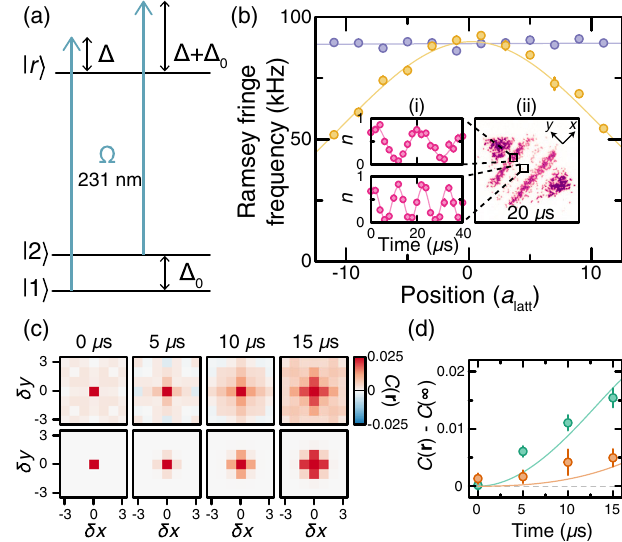
FIG. 2. Measuring Rydberg-dressed interactions with many- body Ramsey interferometry. (a) Energy level diagram for 6 Li showing that the dressing of the other hyperfine ground state cannot be ignored. Here, Δ = 2 π is varied between 30 and 100 MHz, while Δ 0 = 2 π ¼ 75 . 806 ð 1 Þ MHz. (b) Ramsey fringe frequency measured at a detuning of Δ ¼ 2 π × 100 MHz at different positions in the cloud. The frequency is almost constant along the propagation direction of the beam (purple). In the transverse direction (yellow), it varies rapidly as expected for a FIG. 1. Realization of a t − V model with Rydberg dressing. tightly focused Gaussian beam. Insets: (i) Ramsey oscillations at (a) The Rydberg-dressing beam propagates along the x direction two representative positions in the cloud. (ii) Sample image of of the lattice, effectively decoupling 1D chains in the y direction one spin state in the cloud at T ¼ 20 μ s. (c) Spin correlations for due to a differential lightshift. Hopping of fermions (red dots) different spin-echo pulse times at Ω ¼ 2 π × 7 . 66 ð 7 Þ MHz and along the x direction is unaffected. Interactions are isotropic. Δ ¼ 2 π × 35 MHz. Measurement (top) and theoretical expect- (b) 6 Li pair potentials for dressing to the state j 28 P; 0 ; m − 1 = 2 i calculated using Ref. [50]. The color of ation (bottom). (d) Nearest- (green) and next-nearest- (orange) m l ¼ s ¼ neighbor correlations after subtracting C ð ∞ Þ . Lines correspond the lines represents the overlap with the target pair state to the expected correlations. Experimental error bars correspond ( j 28 P; 0 ; − 1 = 2 i ⊗ j 28 P; 0 ; − 1 = 2 i ) coupled via the laser with to standard error of the mean. Rabi coupling Ω and detuning Δ from the target state. Inset: calculated dressed potential for Ω ¼ 2 π × 7 . 66 MHz and Δ ¼ 2 π × 35 MHz taking into account the overlaps to all pair potentials (orange solid line). The dashed green line represents the expected dressed potential for a simple van der Waals potential with C 6 ¼ h × 90 . 19 MHz a 6 . Pink points are the latt interaction at each lattice distance taking into account the wave- function spread of the